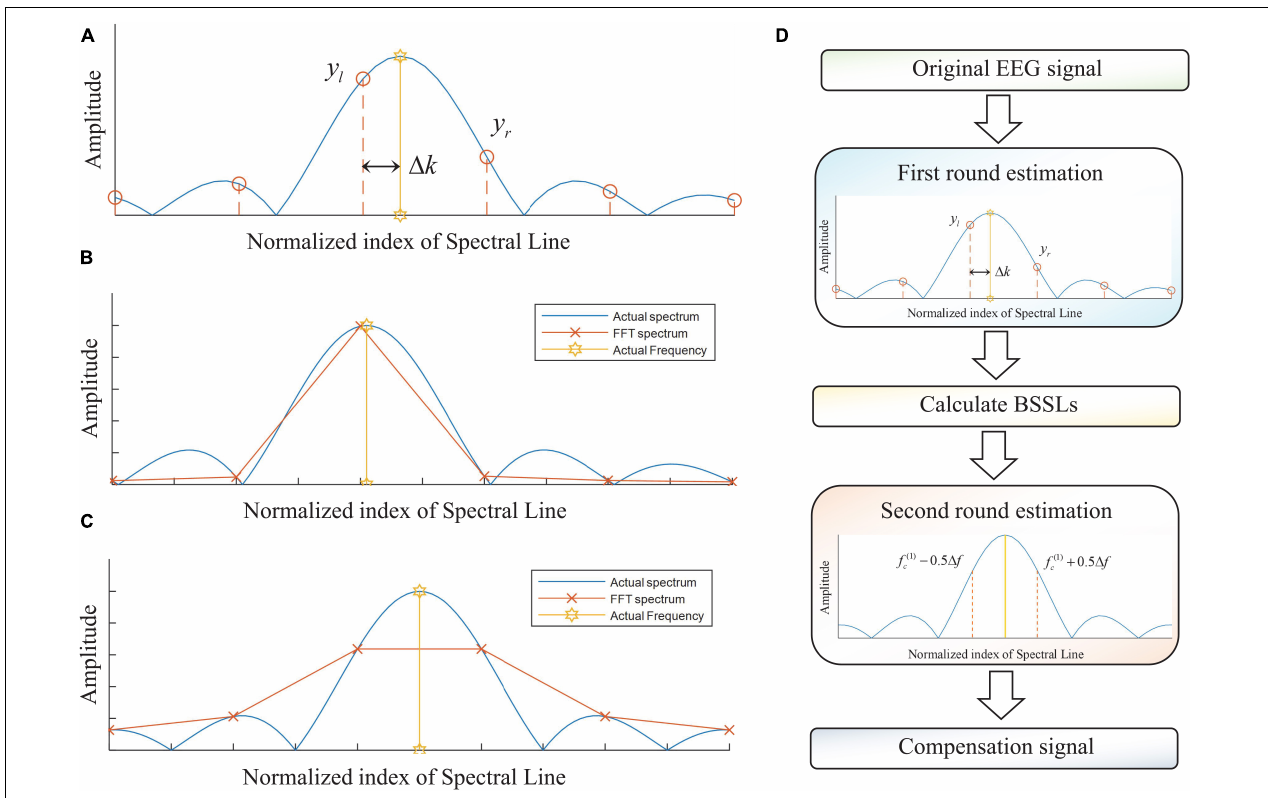
FIGURE 2 | (A) Mathematical model for the RBSC; (B) RBSC for small normalized frequency error; (C) RBS for normalized frequency error (cid:49) k = 1 / 2; and (D) the flowchart of the